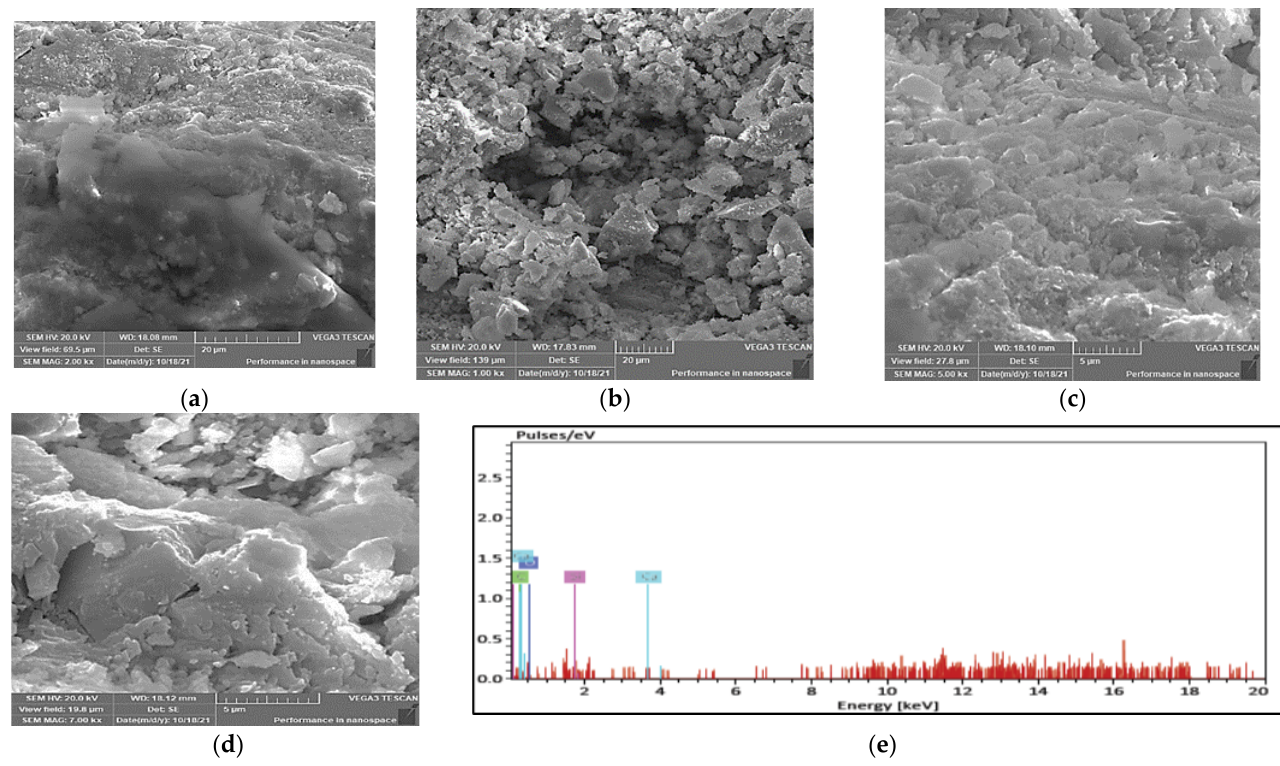
Figure 15. SEM with various magnification factors ( a – d ); ( e ) EDX for the mix UHPSCC 7 at normal curing temperature.